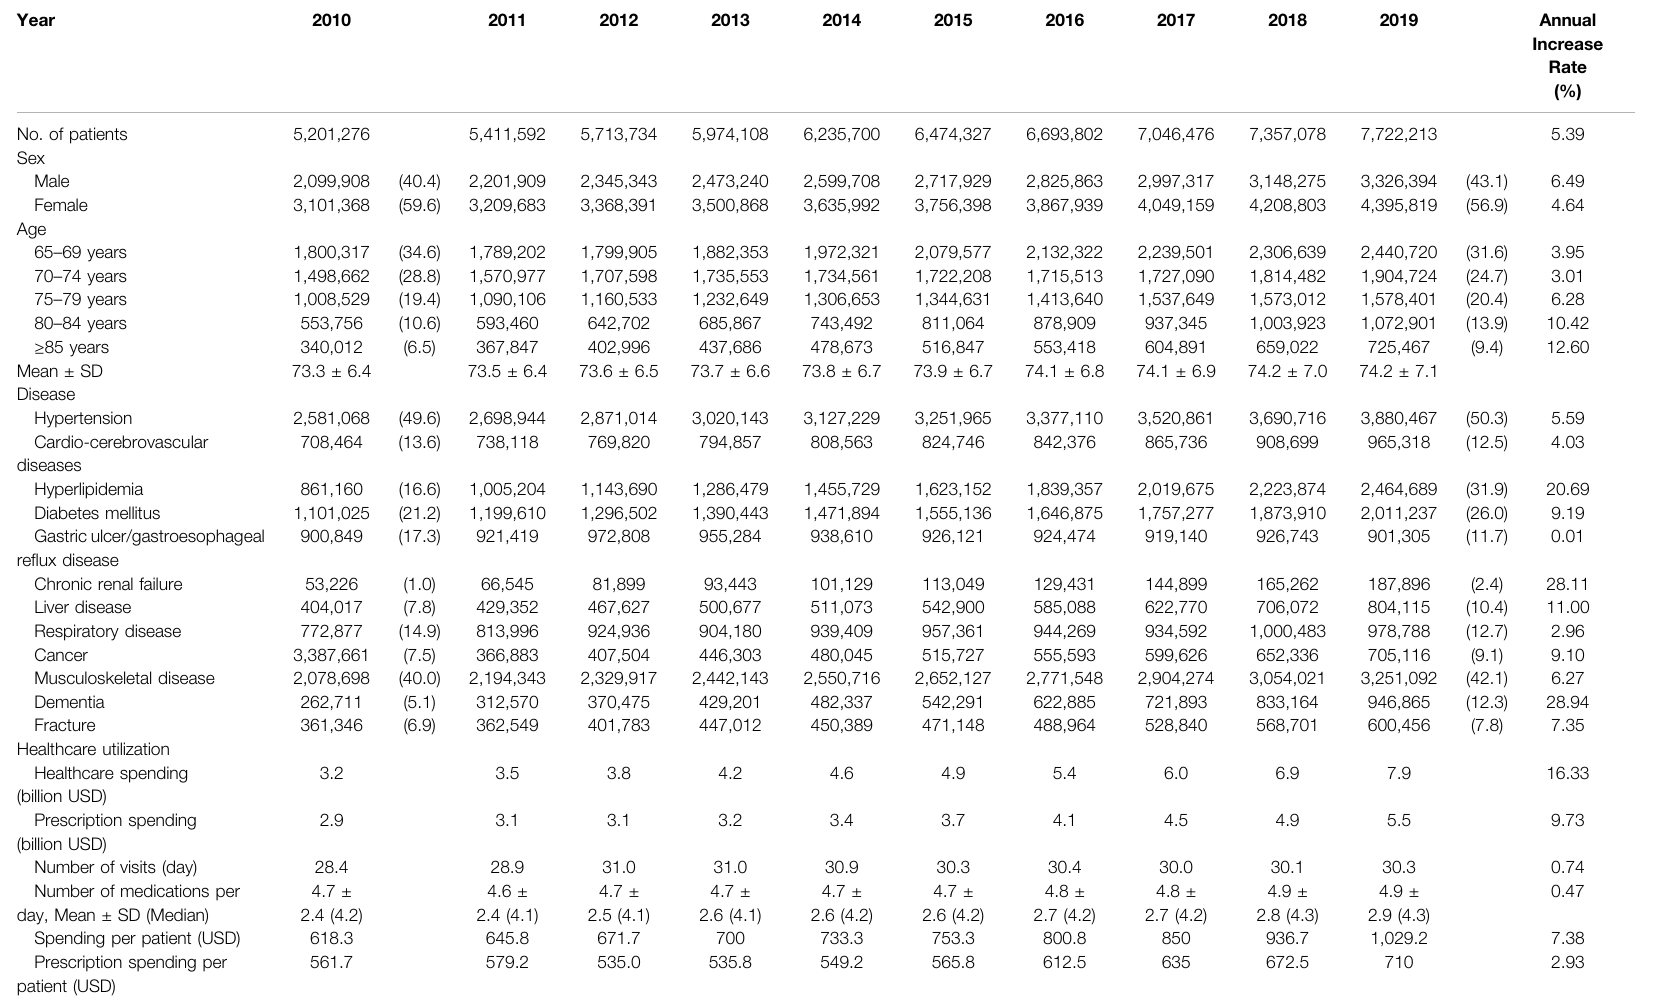
TABLE 1 | General characteristics of elderly patients with outpatient